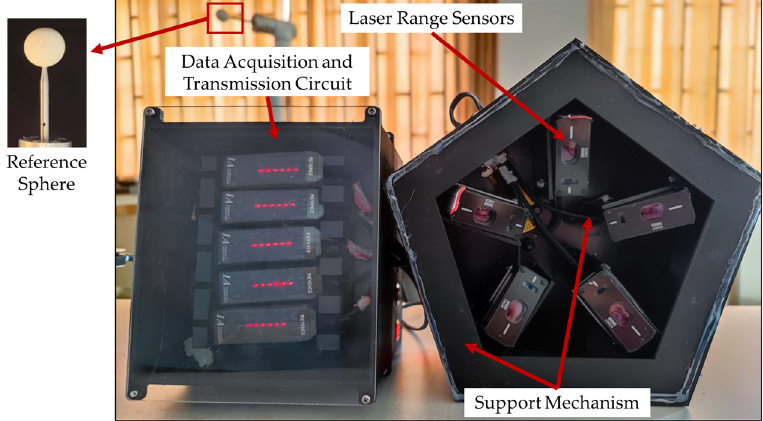
Figure 1. The spatial position measurement system (SPMS).